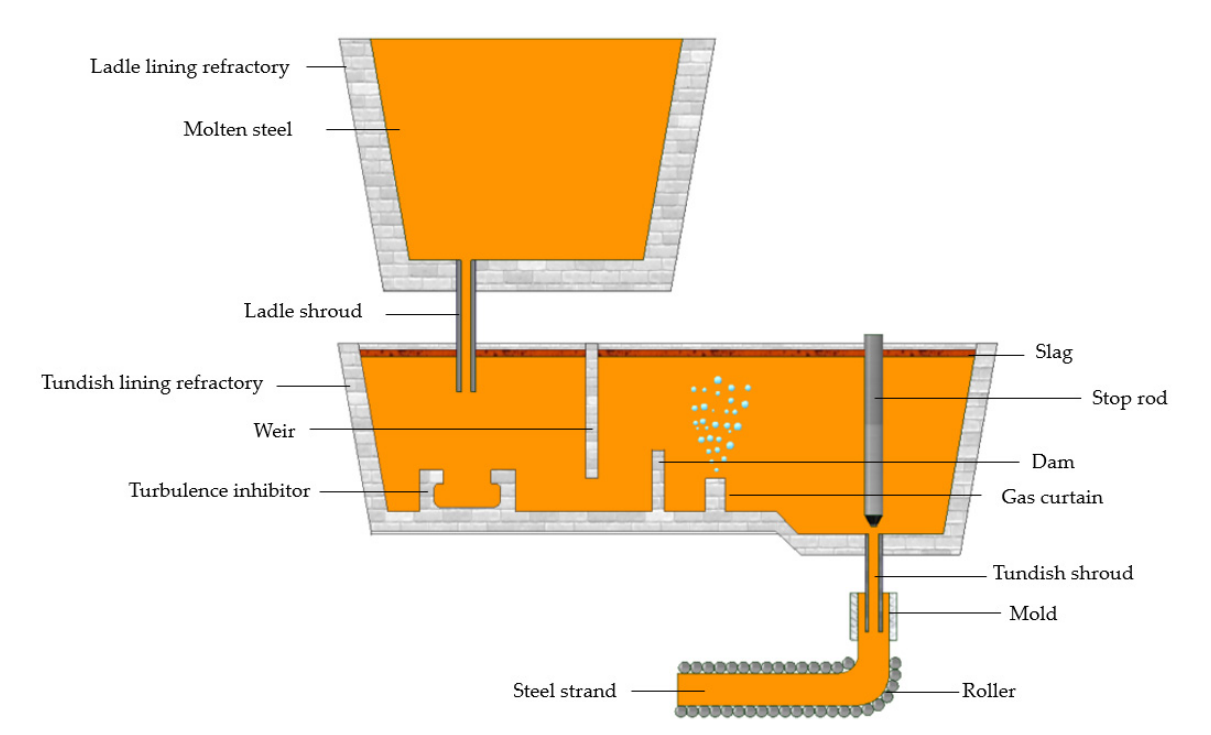
2 of 20 Table 1. Summary of modeling studies on flow control devices in tundish. Reference